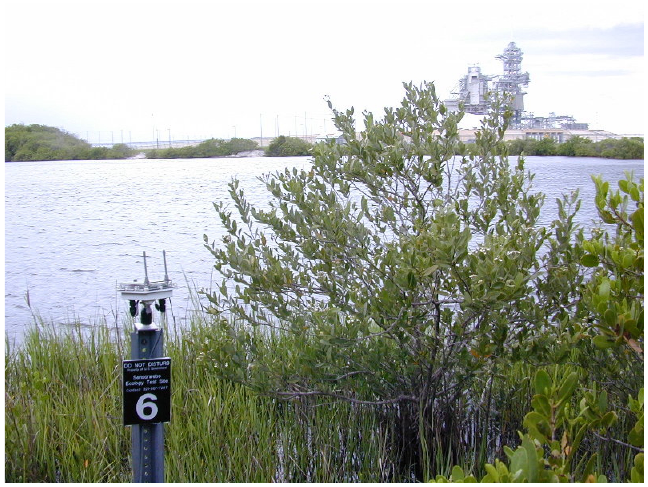
Figure 13. Sensor Web 3 pod deployed at the Kennedy Space Center. Note shuttle launch Pad 39A less than 1 mile from the